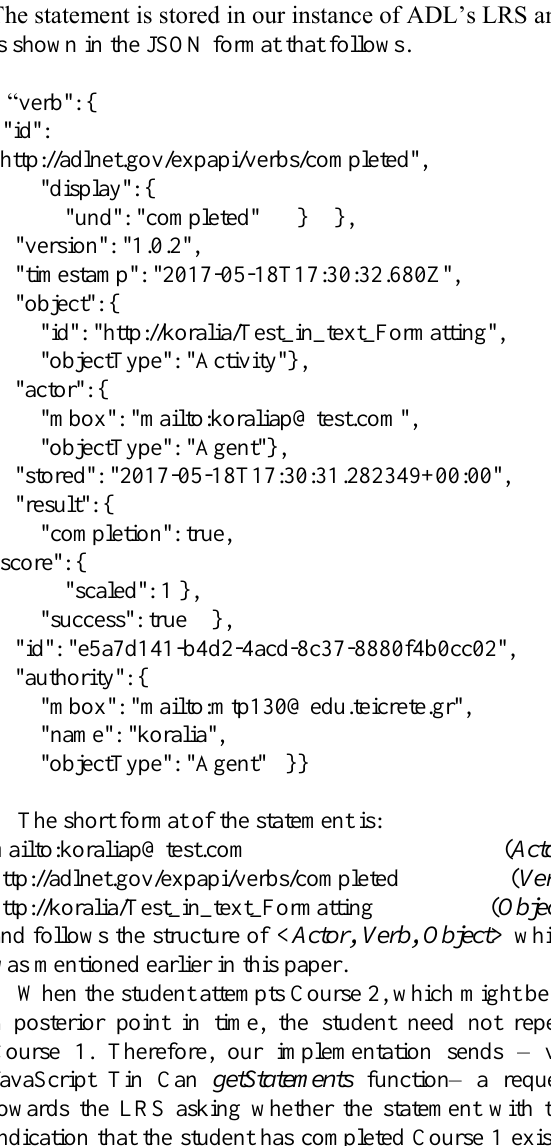
Figure 4. xAPI supports a distributed architecture, where statement streams can originate from diverse sources and may be delivered to several endpoints.